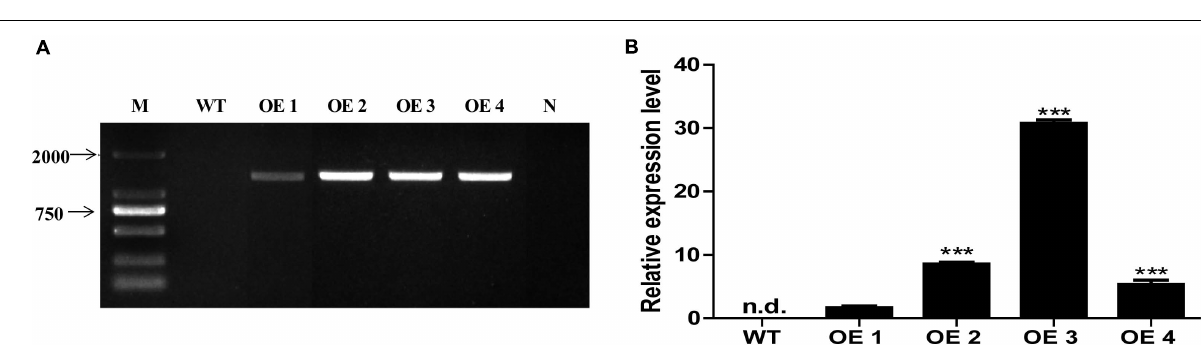
FIGURE 3 | The identification and selection of overexpression Arabidopsis . (A) Genomic DNA PCR analysis of HcTOE3 gene from WT and four transgenic lines. M, DNA marker; N, negative control using water as template. (B) Relative expression of HcTOE3 in WT and four transgenic lines with AtActin2 as an internal control using qRT-PCR. Data represented the average of three biological replicates. Significant differences were at *** p <